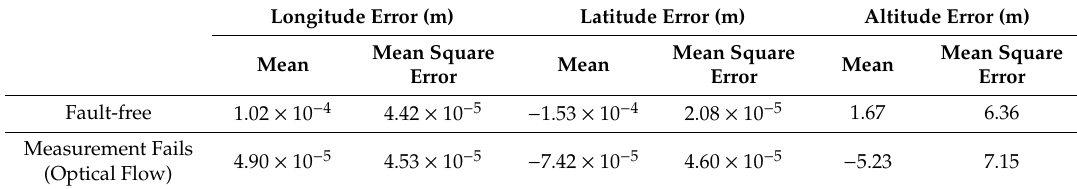
Table 3. The Comparative Data Analysis of Position Errors of the Optical Flow Sensor with and without Faults.